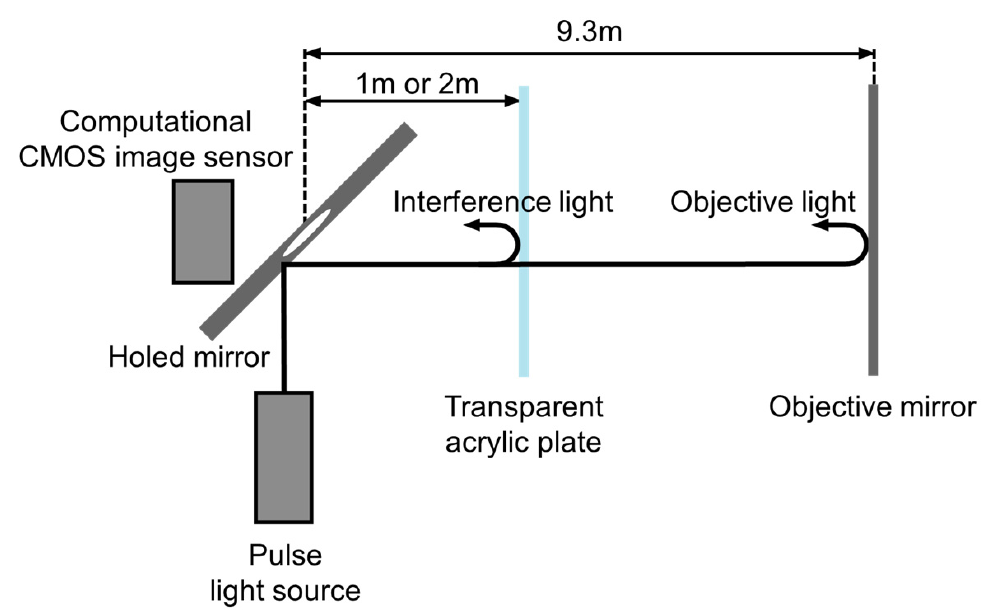
Figure 11. Experimental setup for dual-path ToF depth imaging. The objective mirror and transparent acrylic plate constitute dual-path interference.